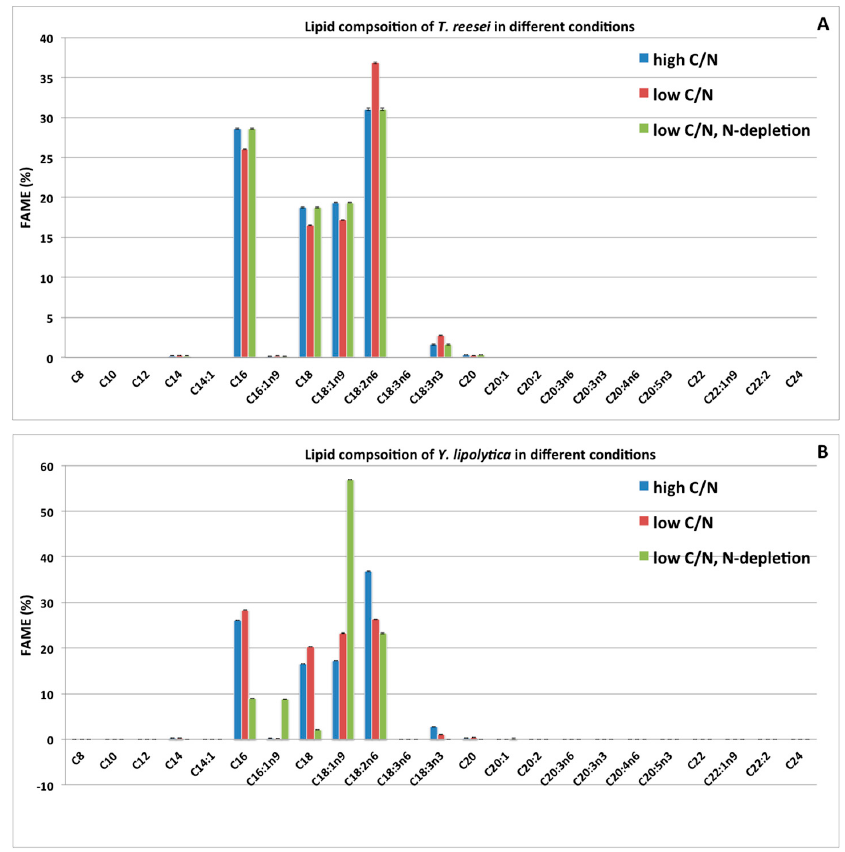
Figure 4. Lipid composition of ( A ) Trichoderma reesei and ( B ) Yarrowia lipolytica in different minimal media with a high C/N ratio, a low C/N ratio, and a low C/N ratio with nitrogen depletion, respectively. Data show mean value with standard deviation from technical triplicate samples of one representative experiment.